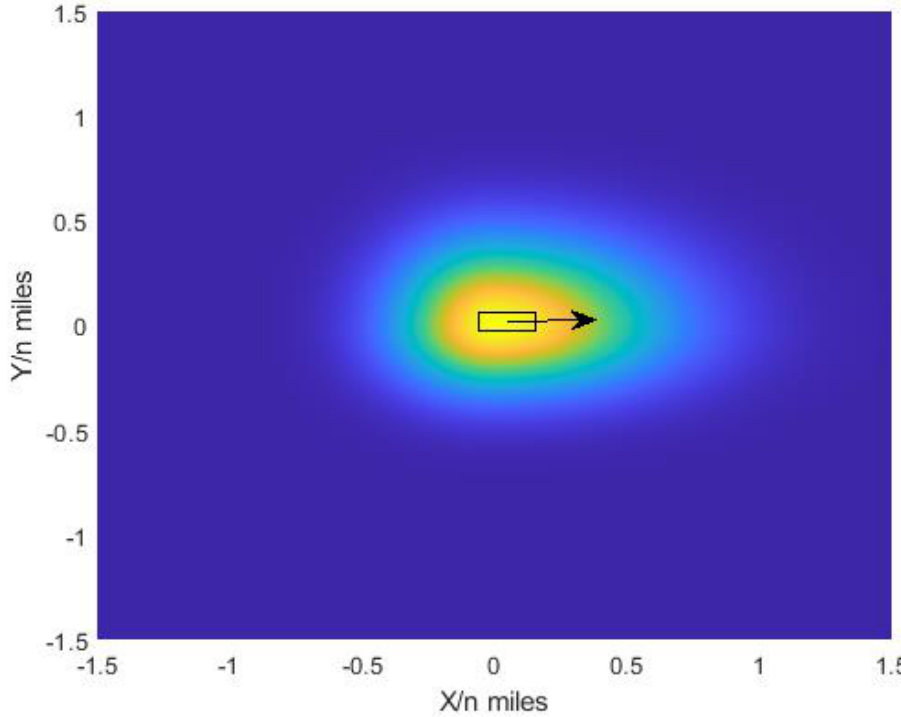
Figure 15. Schematic diagram of the collision risk model.